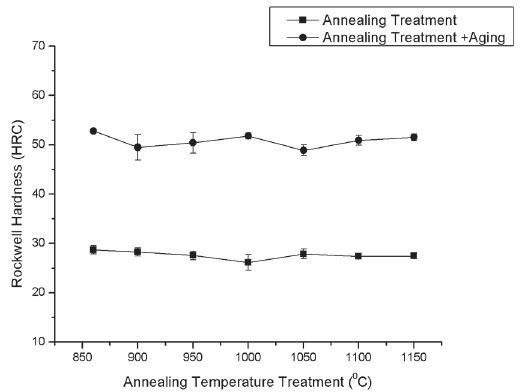
Figure 5: Results of the Rockwell Hardness tests of the solution treatment samples and solution treatment + aging samples.